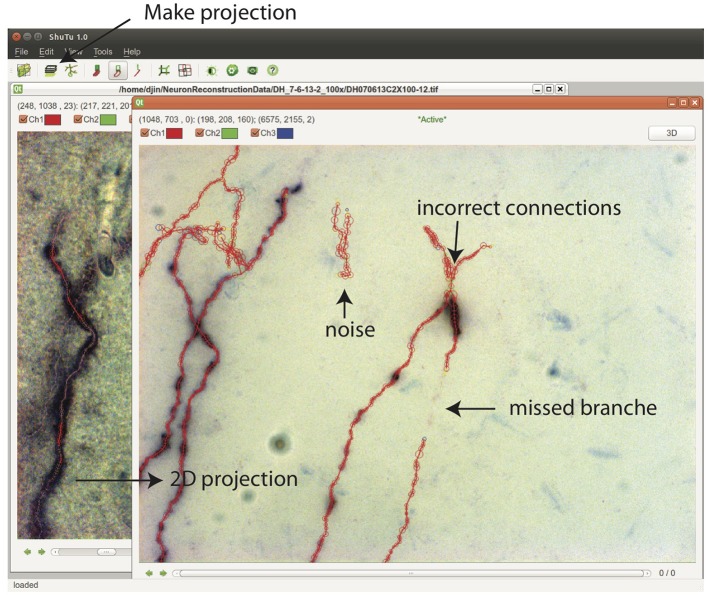
In the Stack View, clicking on the Make Projection button creates the 2D projection of the tiff stack and the SWC structure. It is easy to spot mistakes in this view. SWC points can be removed and their properties changed. The connections between SWC points can be modified. Selecting one SWC point and pressing z locates the points in the Stack View for further examination and modification.